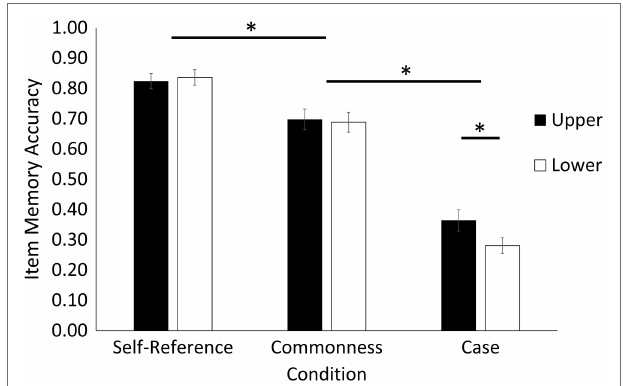
FIGURE 2 | Item memory (explicit memory) as a function of encoding condition and case. Item memory results showed a self-reference effect, and further indicated a case enhancement effect for words presented in upper compared to lower case, but only in the case condition. Error bars represent standard error. Asterisks denote statistical difference at p <